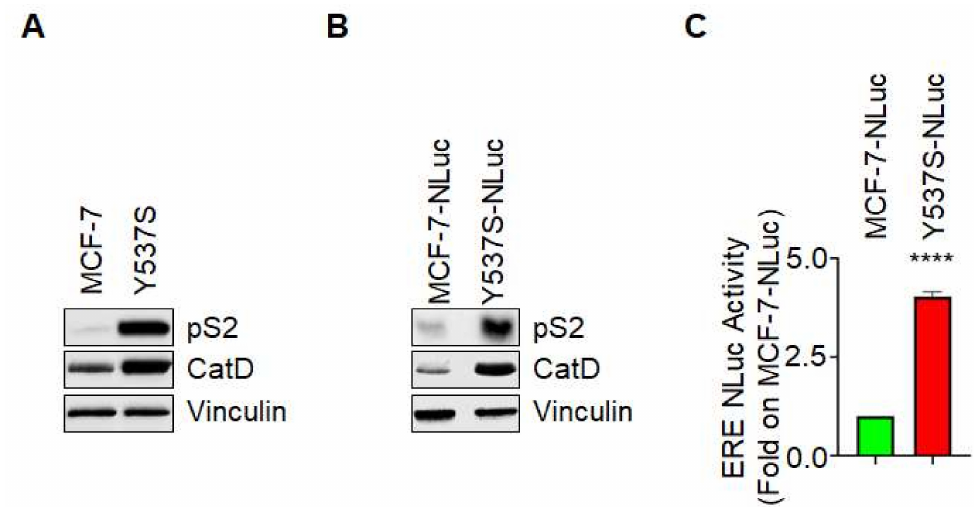
Figure 1. Characterization of Y537S NLuc cells. Western blotting of presenilin-2 (pS2) and cathepsin D (Cat D) expression in MCF-7 and Y537S cells ( A ) and MCF-7-NLuc and Y537S-NLuc cells ( B ). ( C ) Basal ERE-NLuc activity was measured at 24 h in MCF-7-NLuc and Y537S-NLuc cells. Significant differences with respect to the MCF-7-NLuc sample were determined by unpaired two-tailed Student’s t -test: **** p <